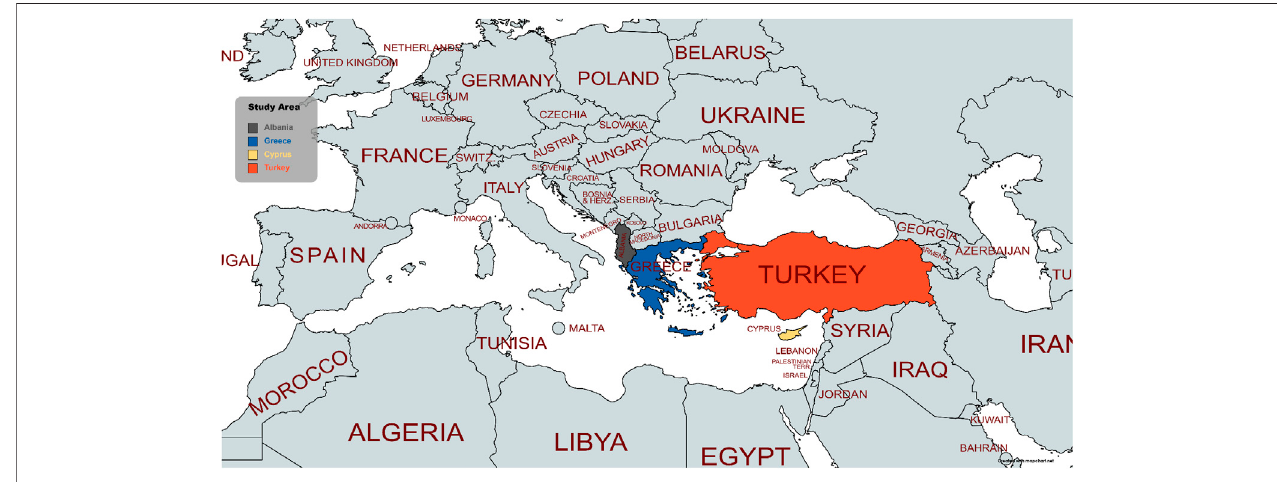
FIGURE 1 | Map of the study